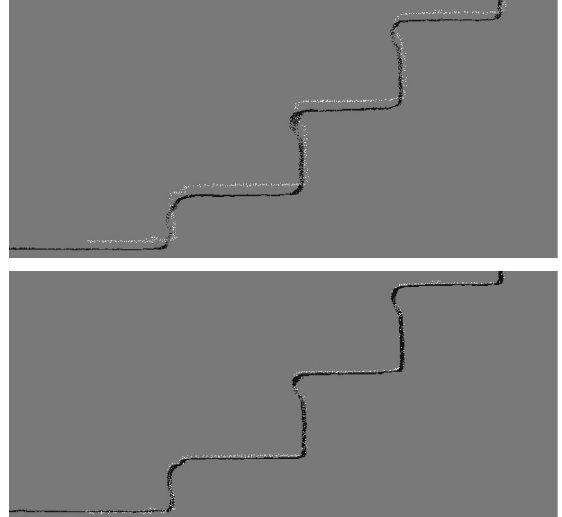
Figure 12. Comparison among the laser scan (white) and photogrammetric point cloud (black). On top the first elaboration using the 5D and the sigma 8mm, in the bottom the Figure 11. Residual errors for the different elaboration during the photogrammetric process.